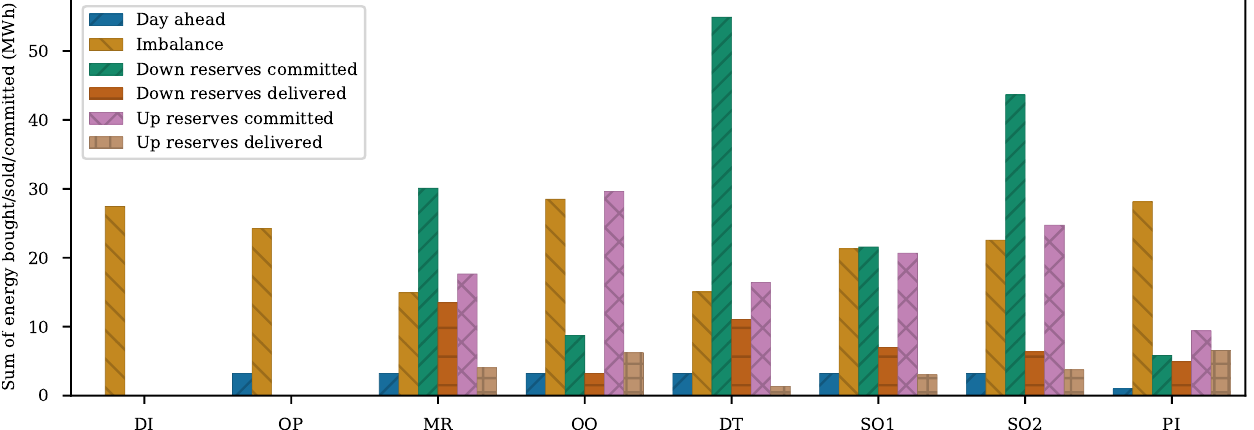
Figure 4. Shares of energy bought and sold in DA and imbalance markets, and shares of energy committed and delivered as